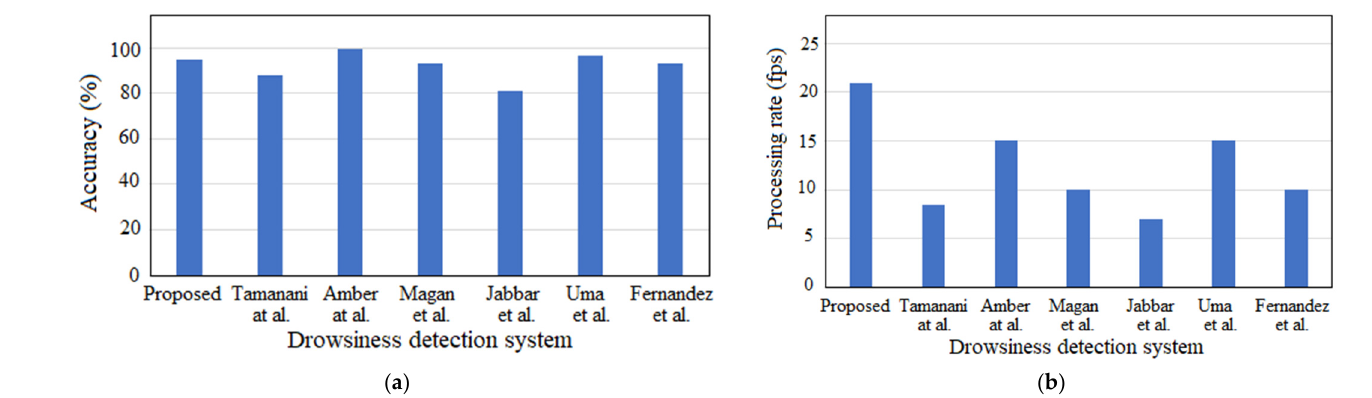
Figure 29. Performance of proposed drowsiness detection system compared with other schemes previously by Tamanin et al. [14], Amber [17], Magan et al. [18], Jabbar et al. [19], Uma et al. [20], Fernandez et al. [21] in terms of ( a ) its detection accuracy and ( b ) the processing rate measured in terms of the number of frames per seconds when it operates in real time. Table 6. Performance comparison for the detection of several driver’s drowsiness and/or distraction levels. × means that the function is not available, ✓ the function is available, ‐ not reported.